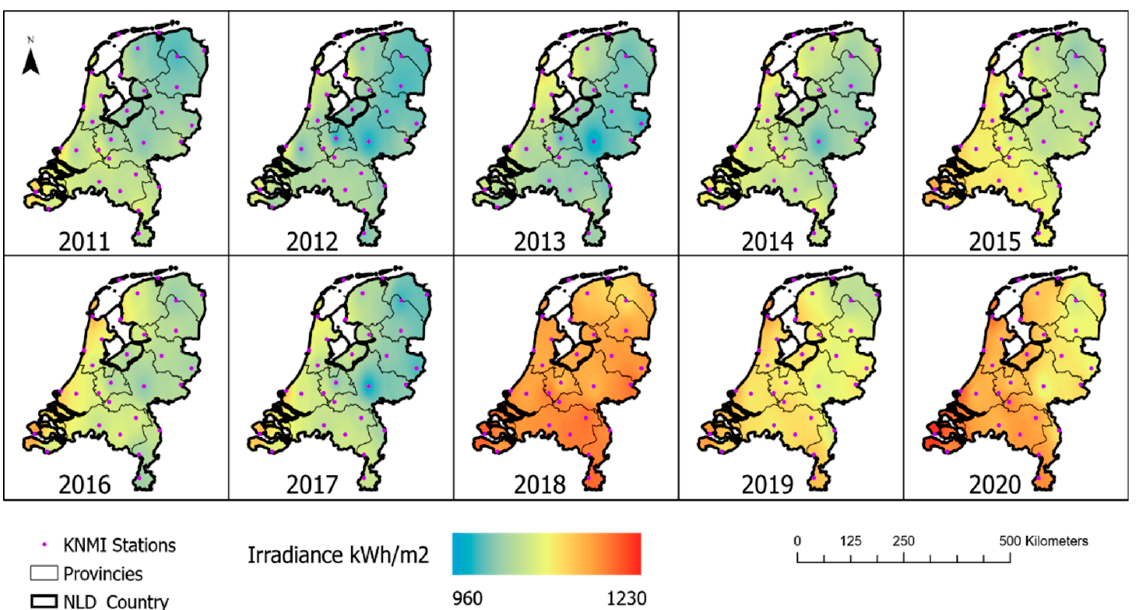
Figure 3. Annual global horizontal irradiation in kWh/m 2 derived from KNMI stations across Netherlands for the years 2011–2020. Data have been interpolated to create a continuous irradiation map. The locations of the KNMI stations are also indicated as dots in the irradiation maps.